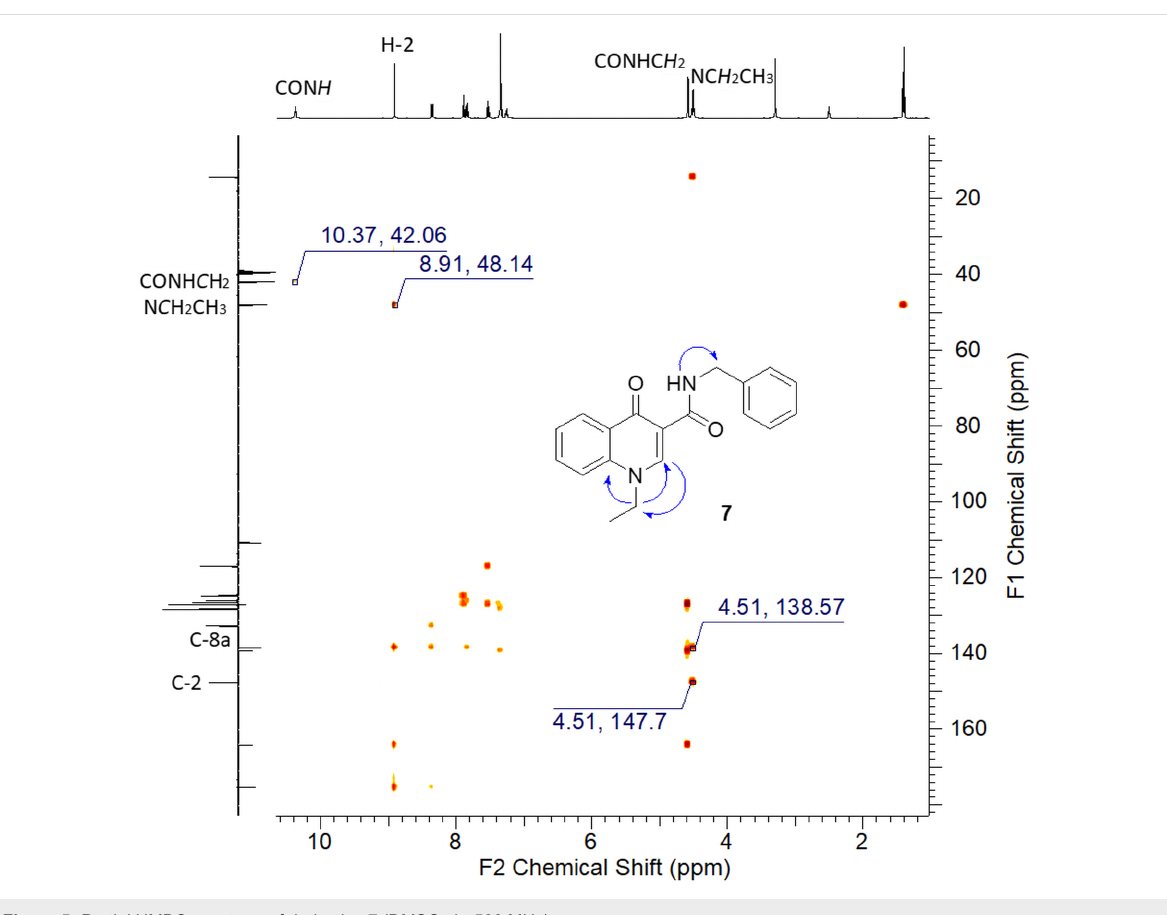
Furthermore, adequate crystals of compound 7 were obtained from a mixture of ethanol and DMSO, which allowed the unam- biguous resolution of its structure as shown in Figure 6.